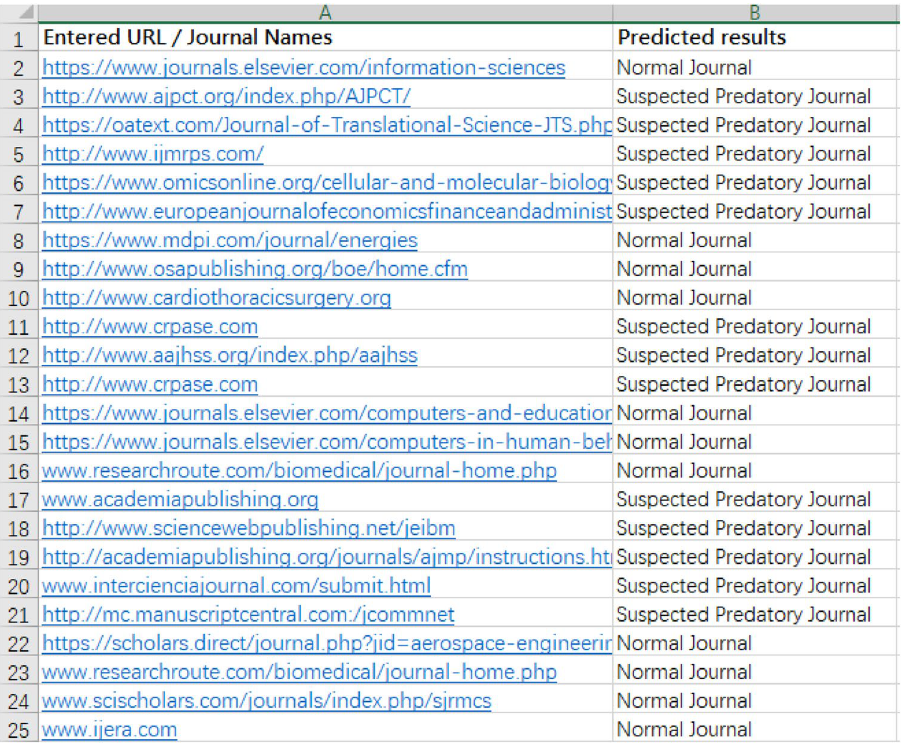
Figure 7. Legitimate and predatory journals’ queried results returned by AJPC system.